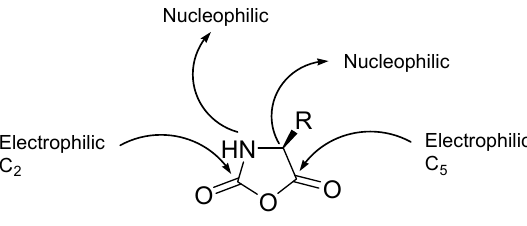
Figure 7. Structure and reactive centers in α -amino acid N -carboxyanhydrides.